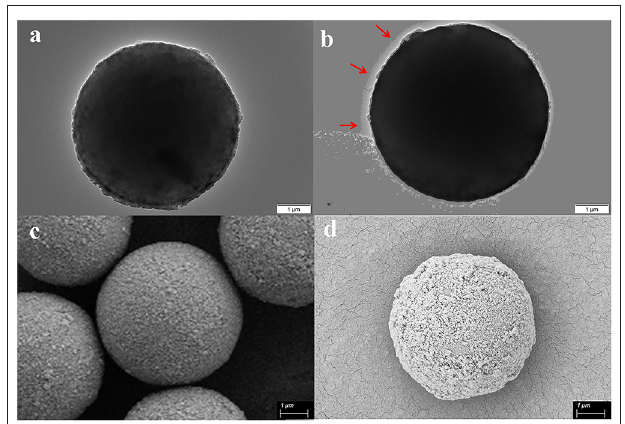
FIGURE 2 | Characterization of magnetic microspheres and MS@PEI@QDs@PEI @MMP-2. (a) TEM image of blank magnetic microspheres. (b) TEM image of MS@PEI@QDs@PEI@MMP-2. (c) The SEM picture of blank magnetic microspheres. (d) The SEM picture of MS@PEI@QDs@PEI@MMP-2.